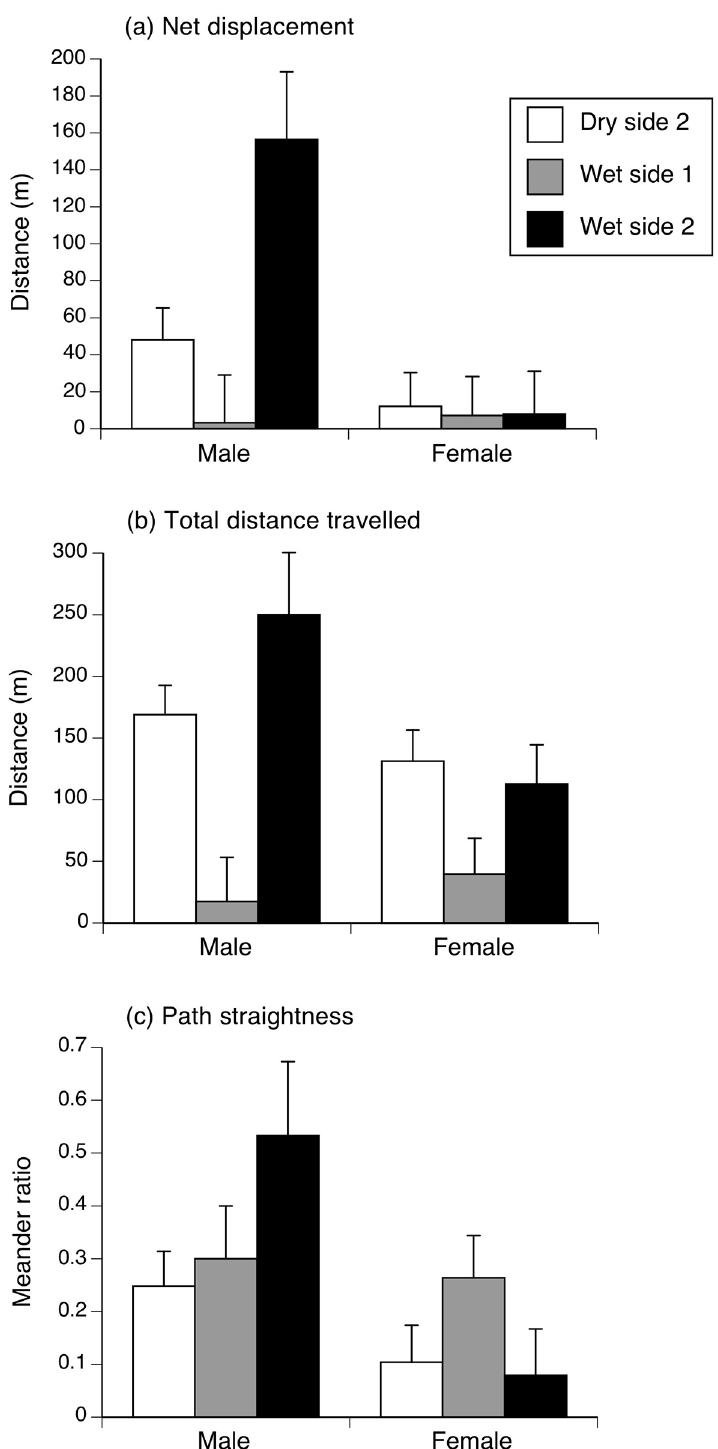
Fig 3. Nocturnal movements of toads. Figure shows movement patterns of 39 spool-tracked male and female cane toads at three sites on Hawai ’ i: (a) net displacement between successive diurnal retreat-sites, (b) total distance travelled, and (c) path straightness (net displacement as % of total distance travelled). Panels show mean values and associated standard errors.